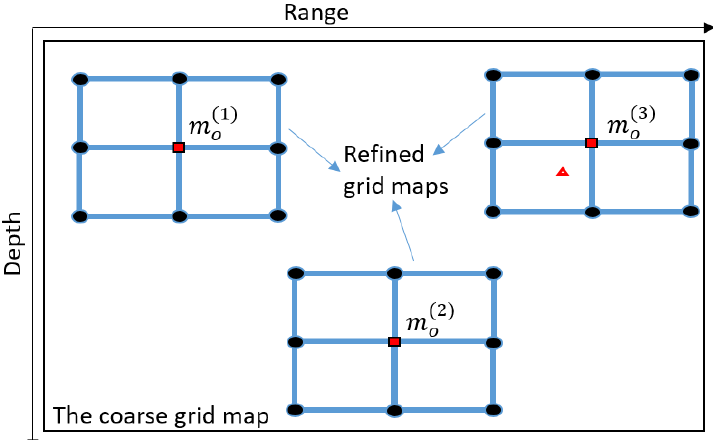
Figure 7. An illustration of multiple refinement areas ( N max = 3 as an example) in the area of interest (See notation in Figure